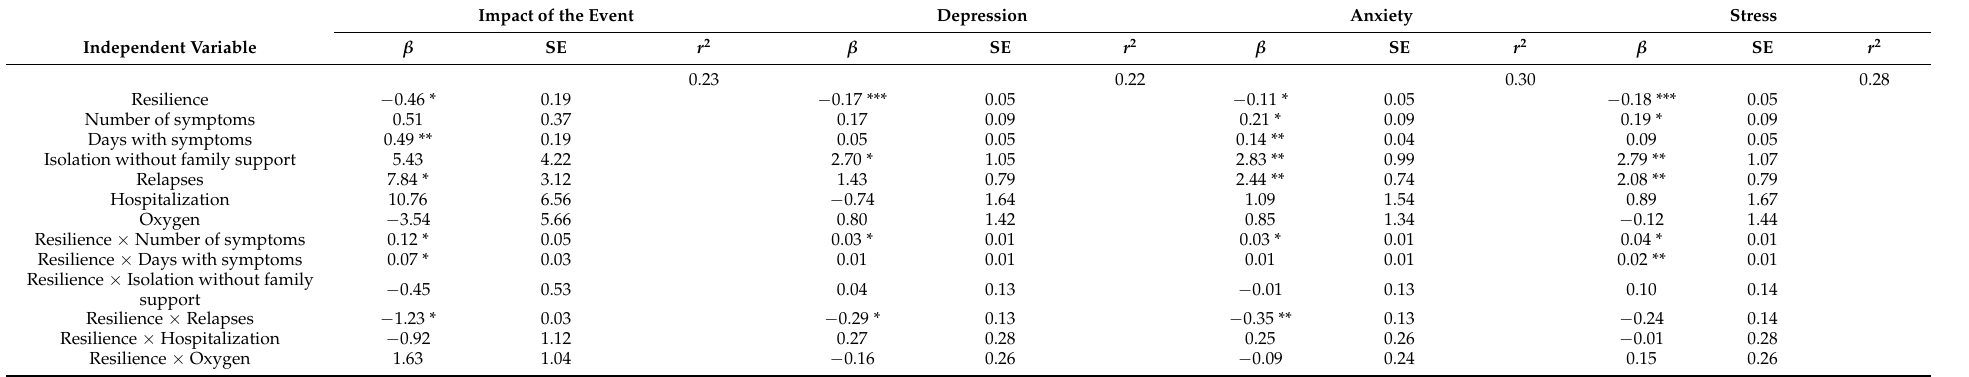
Table 4. Multivariate Regression Models of Mental health of the COVID-19 survivors as a function of disease severity and resilience. Impact of the Event Depression Anxiety